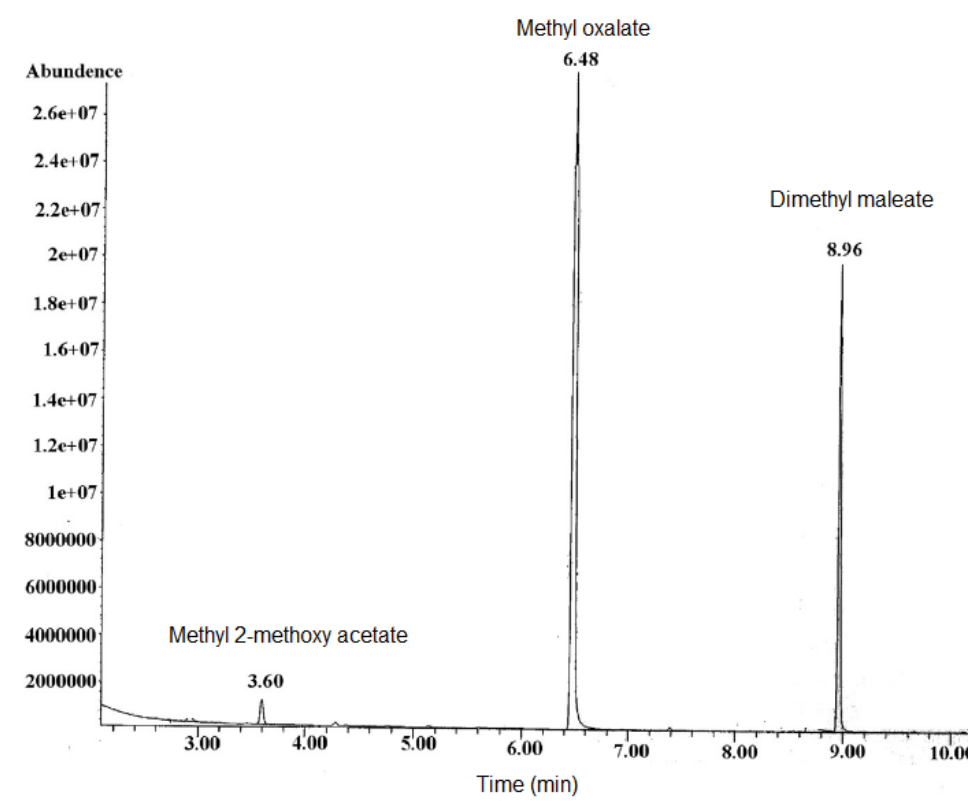
Fig. 6. GC-Chromatogram of the final products of the photocatalytic degradation of 2,4-DCP by Ag/TiO